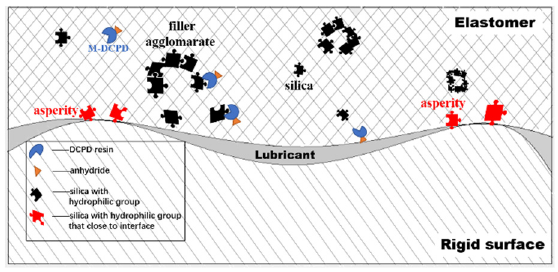
Figure 6. Interaction mechanism of vulcanizates and water effected by M-DCPD resin with anhydride and silica with hydroxy.